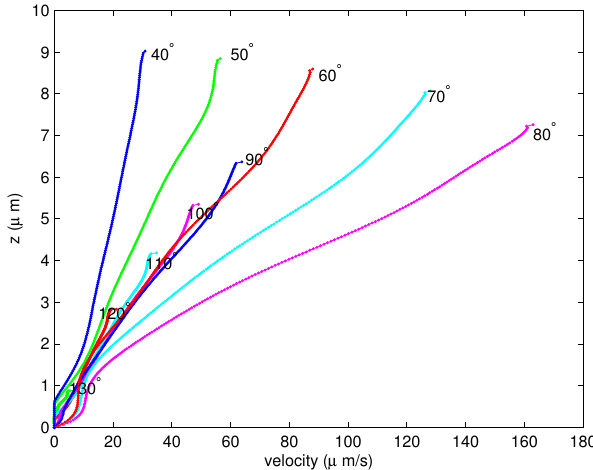
Figure 8. The velocities of PCL fluid for the full forward stroke of the cilia from the angles θ = 130 ◦ to θ = 40 ◦